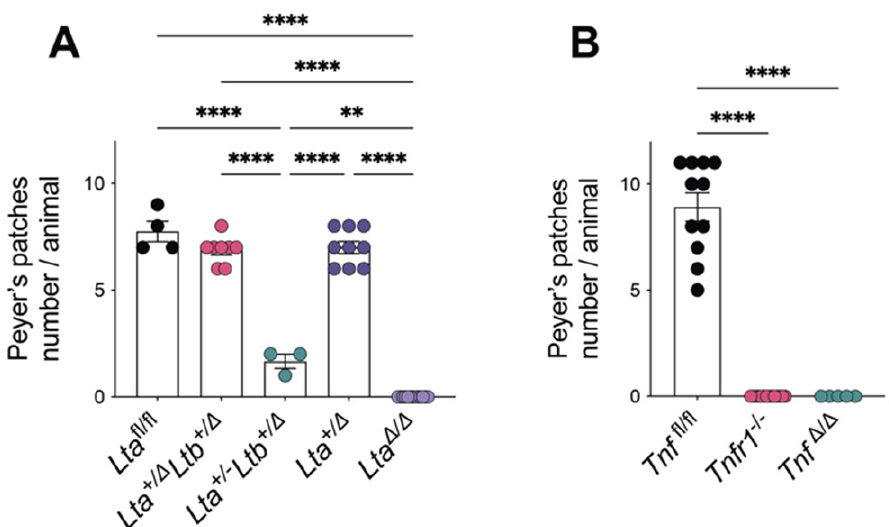
Figure 1. Distinct contribution of various genetic deficiencies involving TNF/LT ligand–receptor system to Peyer’s patch development. ( A ) Peyer’s patches numbers in adult Lta fl/fl ( n = 4), doubly heterozygous Lta +/ Δ Ltb +/ Δ ( n = 8), doubly heterozygous Lta +/- Ltb +/ Δ ( n = 3), single heterozygous Lta +/ Δ ( n = 9), and homozygous Lta Δ / Δ mice ( n = 13); ( B ) Peyer’s patches numbers in adult Tnf fl/fl ( n = 11), Tnfr1 -/- ( n = 14), and Tnf Δ / Δ ( n = 5) mice. Each symbol represents an individual mouse; mean ± SEM. ** p < 0.01, **** p < 0.0001 (one-way ANOVA).